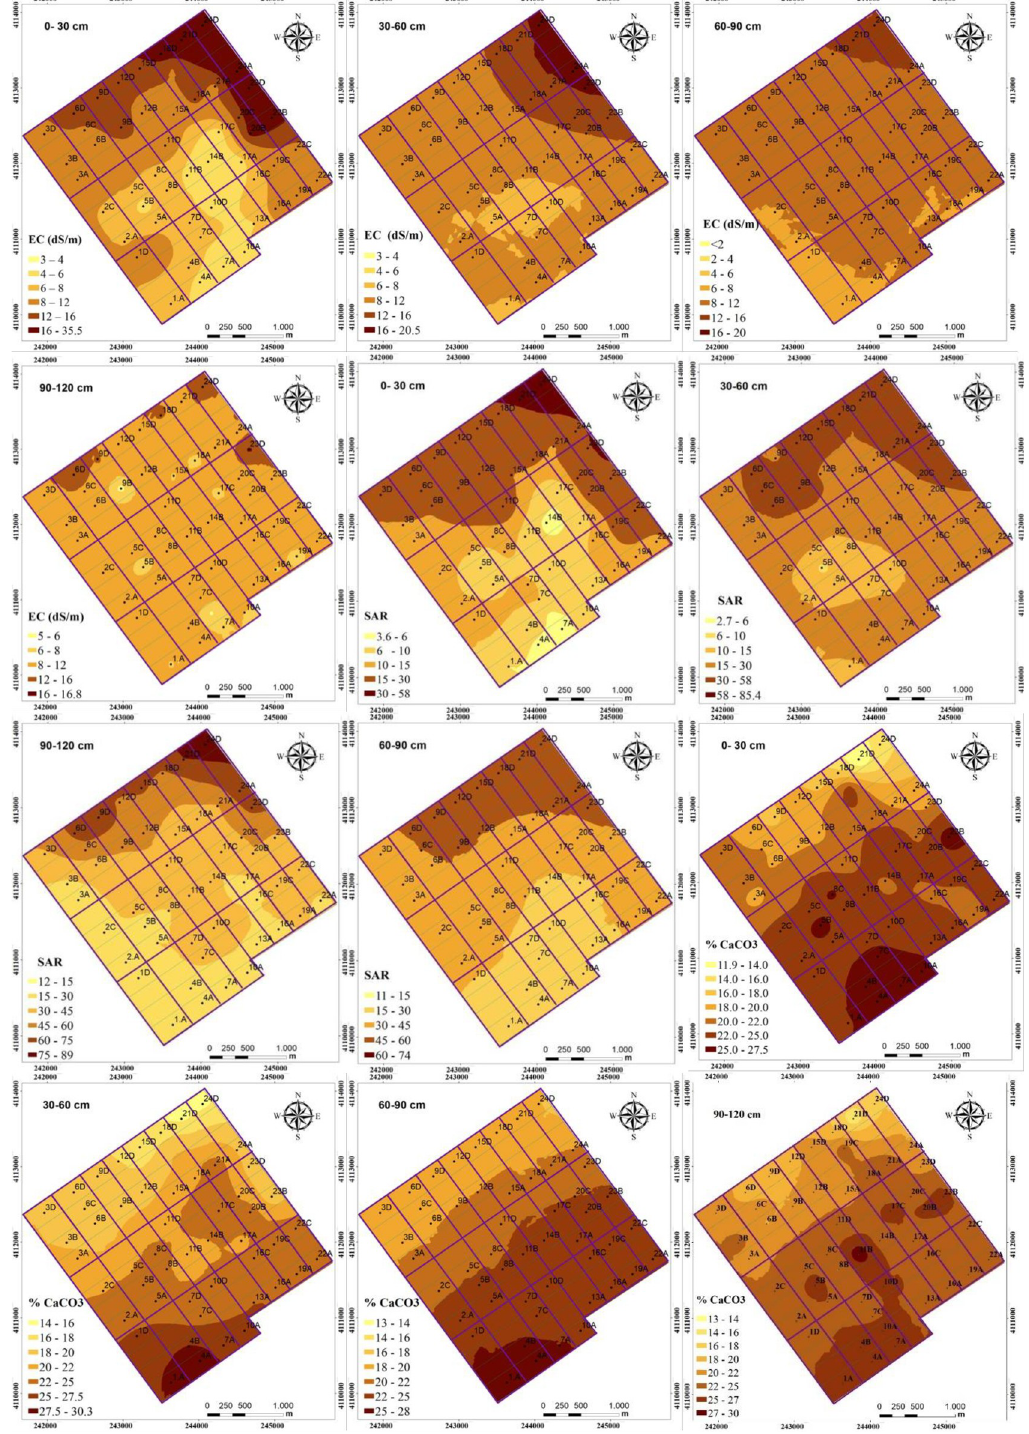
Fig 3. Spatial distribution of electrical conductivity (EC), sodium adsorption (SAR) values and calcium carbonate (CaCO 3 ) contents within 0–120 cm of soil profile.